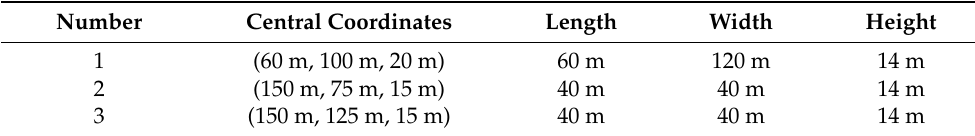
Table 2. Model parameters of